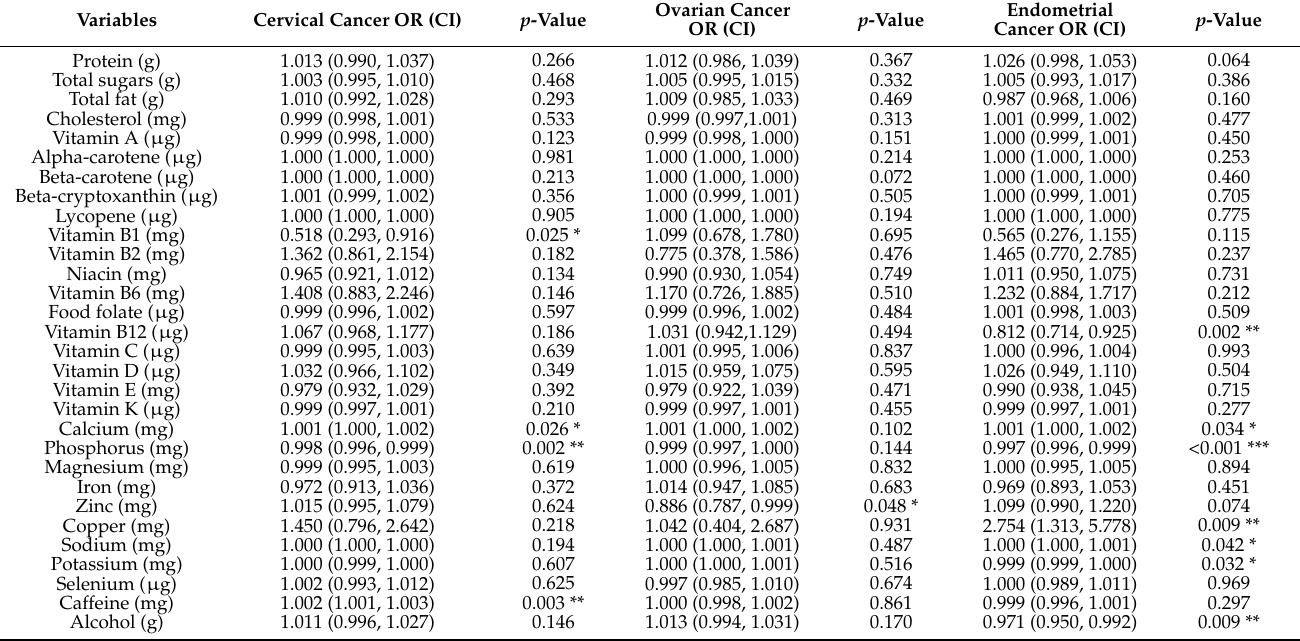
Table 3. ORs with 95% CIs of the associations between dietary intakes, cervical cancer, ovarian cancer and endometrial cancer,